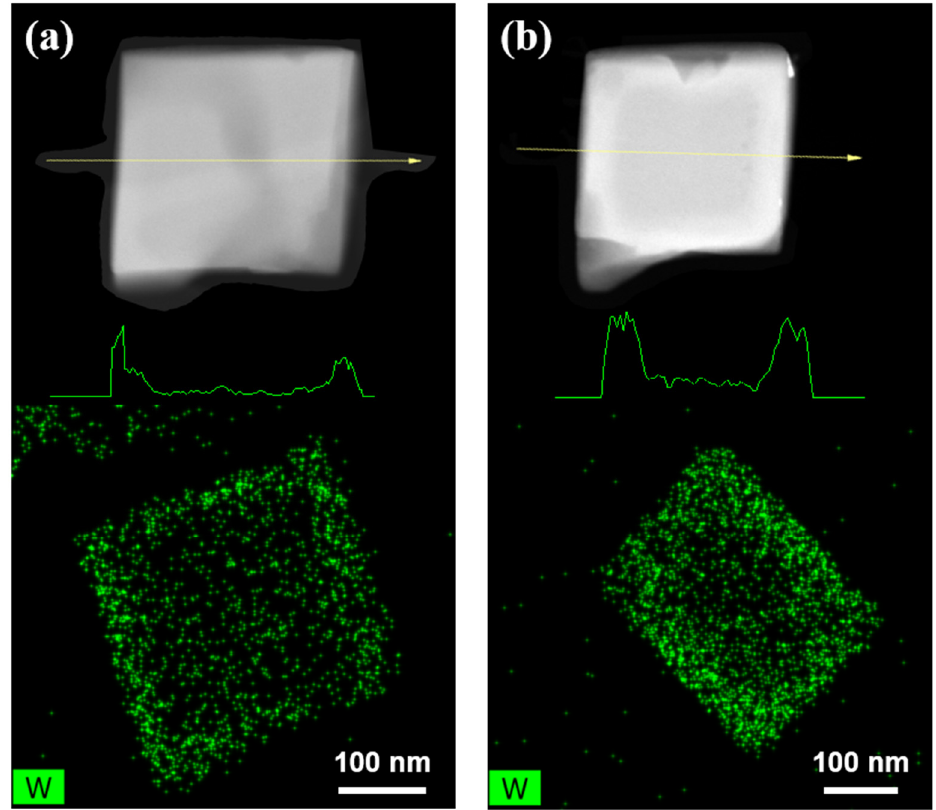
Figure 5. ( Top ) STEM images and ( bottom ) EDS elemental mapping images of ( a ) 1 wt% WO 3 -SSZ-13 and ( b ) 10 wt% WO 3 -SSZ-13 samples.